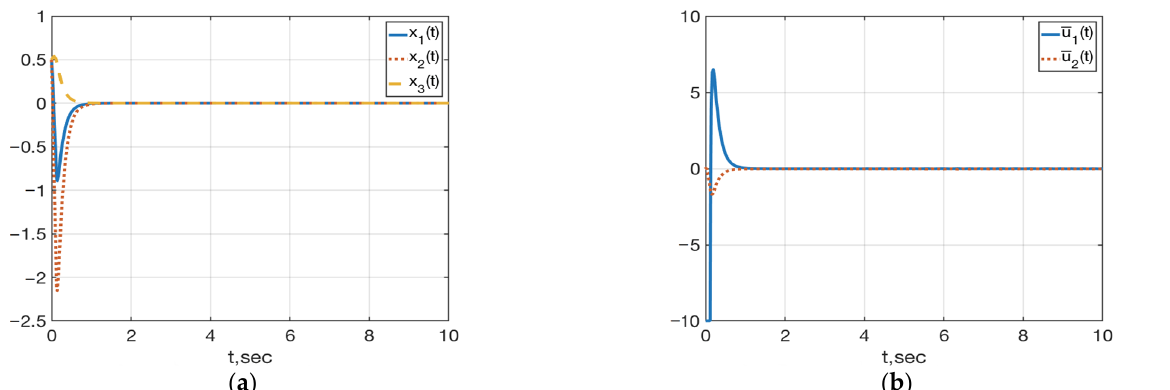
Figure 5. ( a ) Plots of )(),(),( 321 txtxtx ; ( b ) Plots of )(),( (( 1 + α ) A + ( 1 + β ) BF ) x , (59), (69), (70), x ( 0 ) = ( 0.5, 0.5, 0.5 ) T